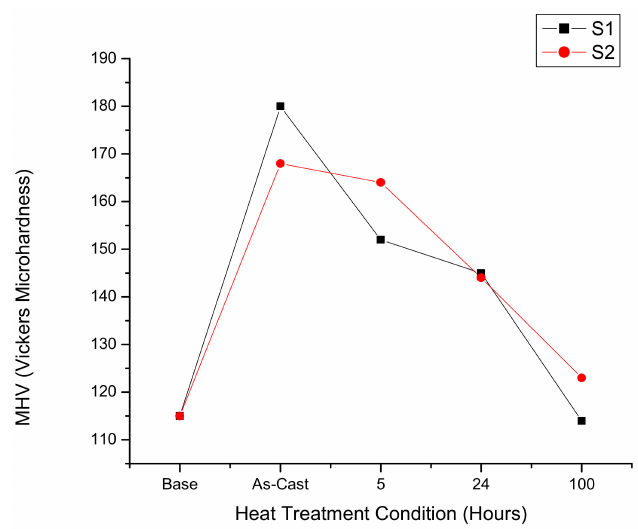
Figure 6. Vickers micro-hardness vs. heat treatment time for all